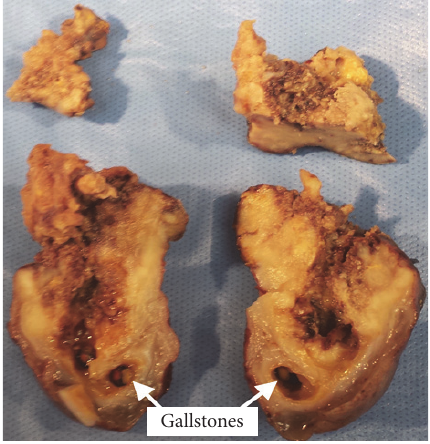
Figure 3: Gross examination reveals diffuse gallbladder wall thick- ening from the tumor mass encompassing the entire gallbladder